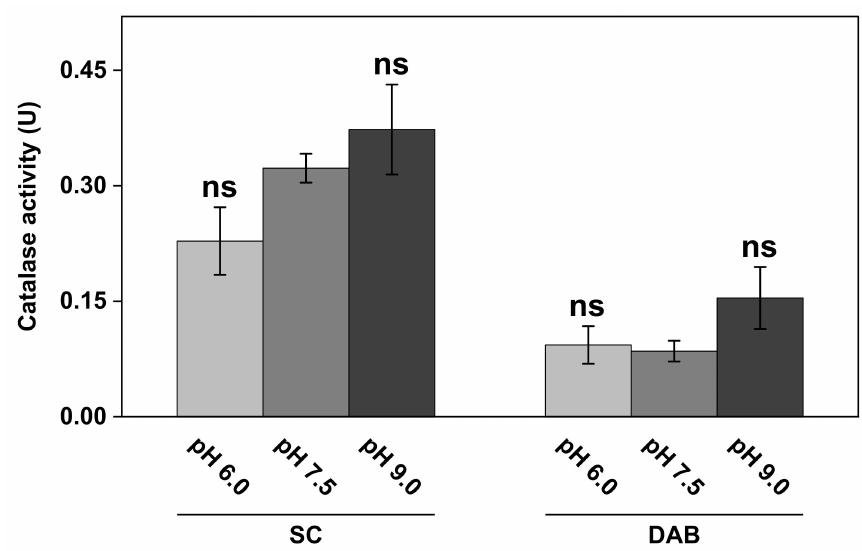
Figure 6. The effect of pH on catalase activity in SC and DAB samples. All experiments were performed in triplicates ( n = 3, mean ± SD) with 10 mM H 2 O 2 and 1.0 mg of SC or DAB samples in 5 mL of PBS. ns = p >